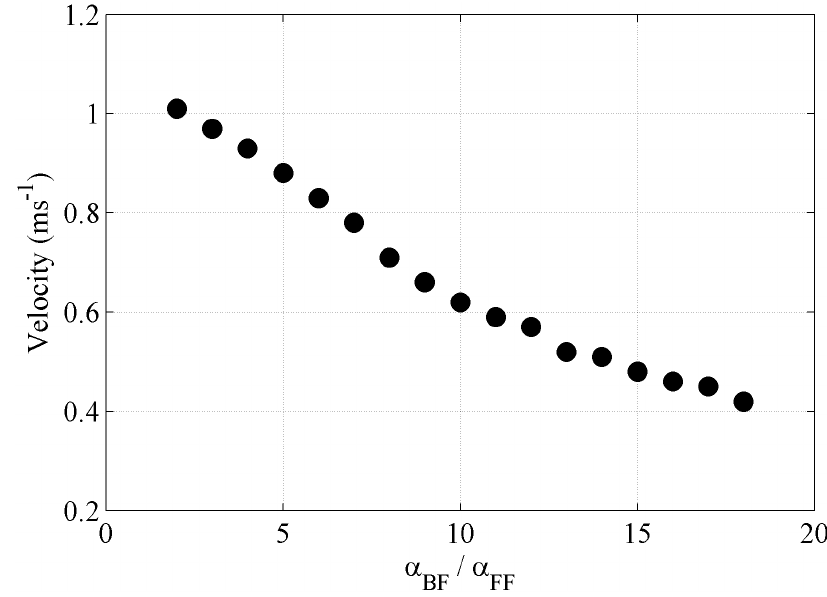
Figure 6. Flow velocity dependence on the ratio between a BF and a FF .